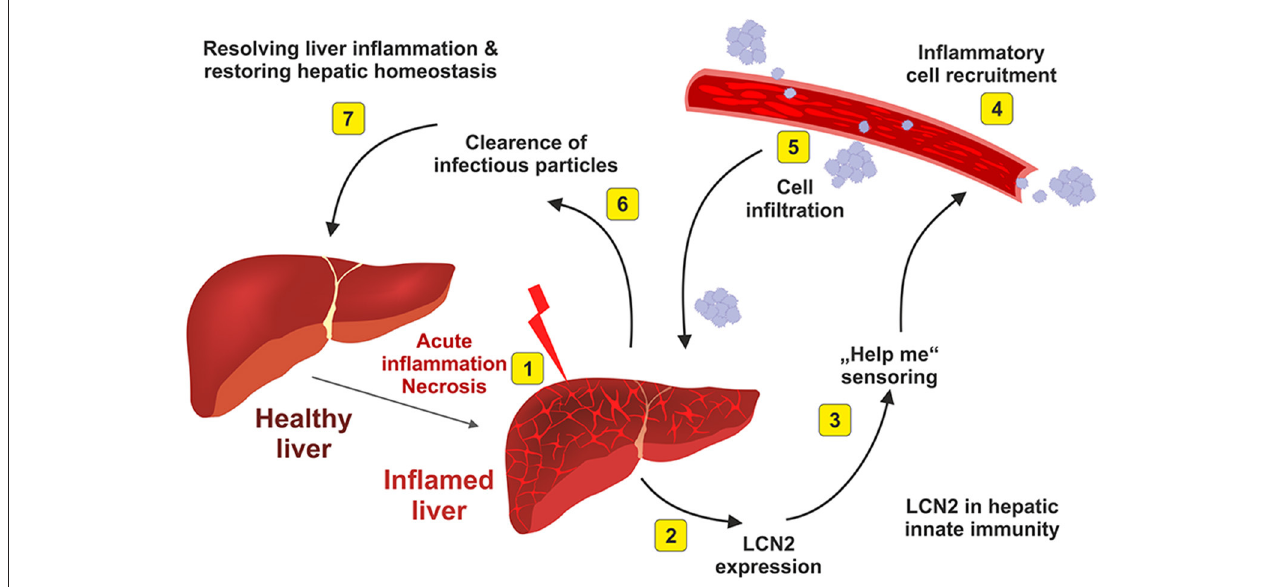
FIGURE 5 | Elevated hepatic LCN2 expression is a physiological indicator of hepatic inflammation. After acute inflammatory stimulus (1), the liver synthesizes and secretes large quantities of LCN2 (2). This physiological response indicates that the liver is inflamed and needs help (3). As a consequence of the emitted “help me” signal, inflammatory blood cells that are necessary to begin the repair are recruited (4) and infiltrate the liver (5). The infiltrating cell populations help to destroy and clear infectious particles (6) and are helpful in restoring tissue homeostasis (7). For more details about this hypothesis are given elsewhere (Asimakopoulou et al.,